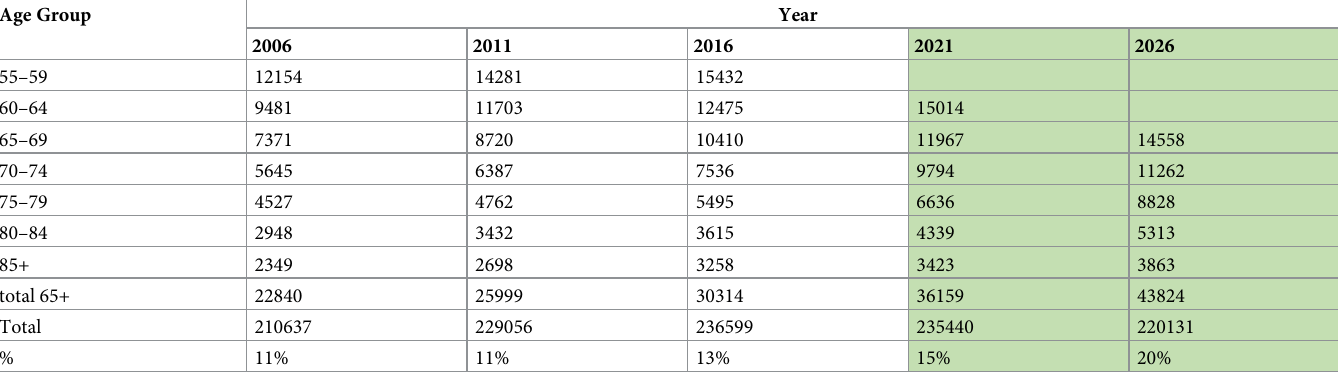
Table 7. Progressive forecasting on elderly population of FCW (Green boxes indicate the estimated results). Age